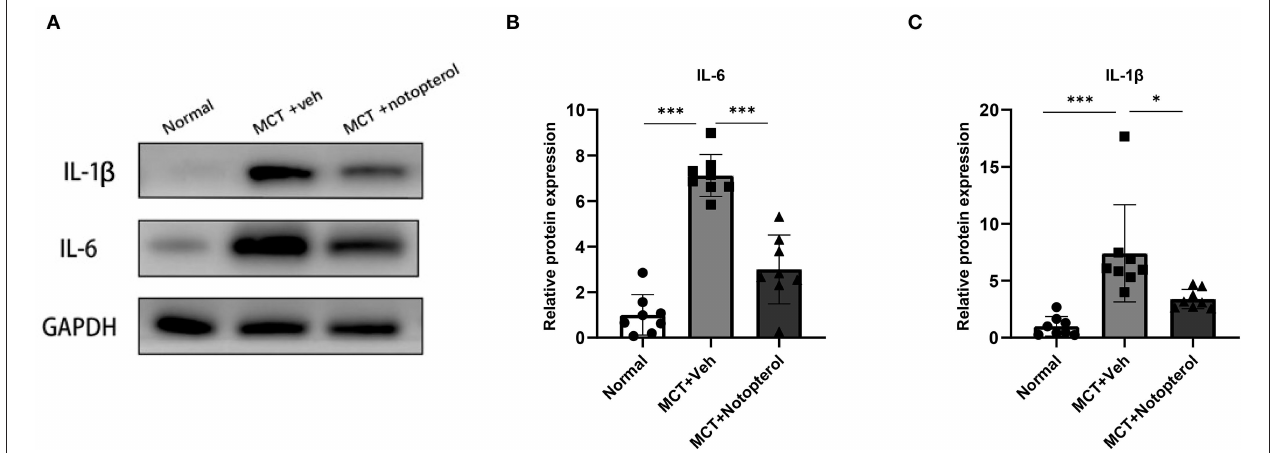
FIGURE 5 | Notopterol attenuates the pro-inflammatory factors in the lungs of PAH rats. (A) Western blots of IL-1 β and IL-6 in lungs; (B) Quantification of IL-1 β expression in the lungs ( n = 8 for each group); (C) Quantification of IL-6 expression in the lungs ( n = 8 for each group). * p < 0.05, *** p <